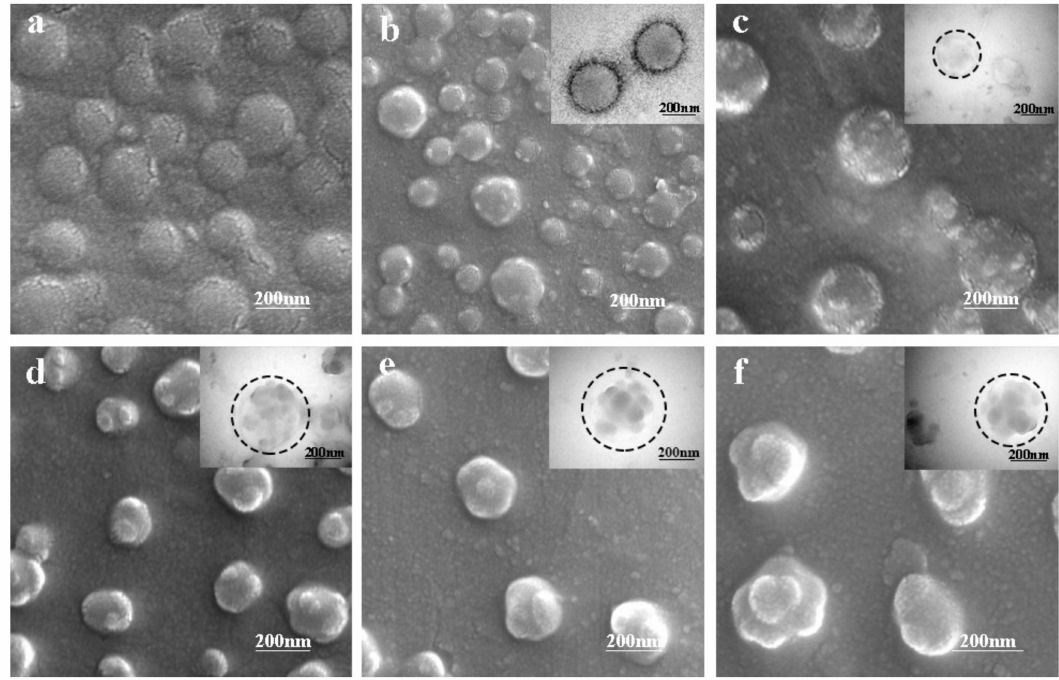
Figure 2. SEM and TEM images of the composite emulsion with different shell growth degrees: ( a ) PVAc core; ( b ) 30 min; ( c ) 60 min; ( d ) 90 min; ( e ) 120 min; ( f ) final